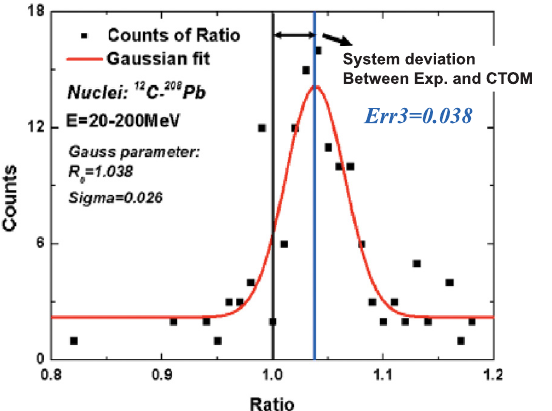
Fig. 7. The comparison of CTOM calculation, the derived cross sections with and without SEP approach in LS, and the experimental data of 27 Al(n,tot).